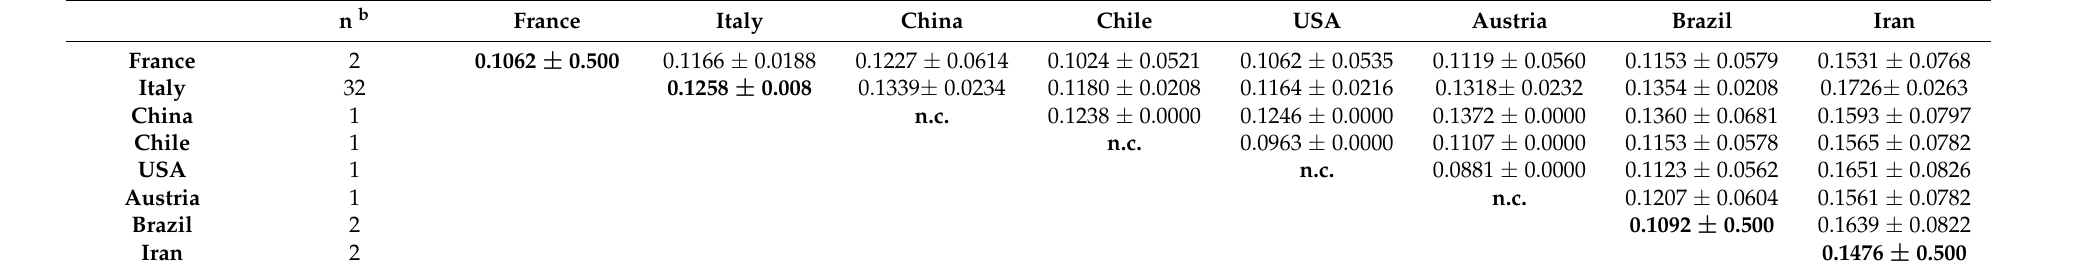
Table 5. Nucleotide diversity a of Grapevine fanleaf virus (GFLV) in different geographical